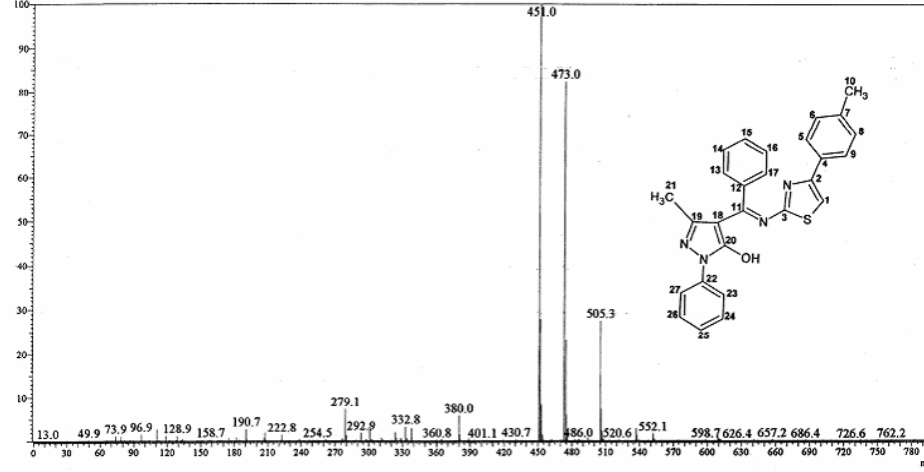
Figure 5 . Mass Spectra of BzPMPAMPT